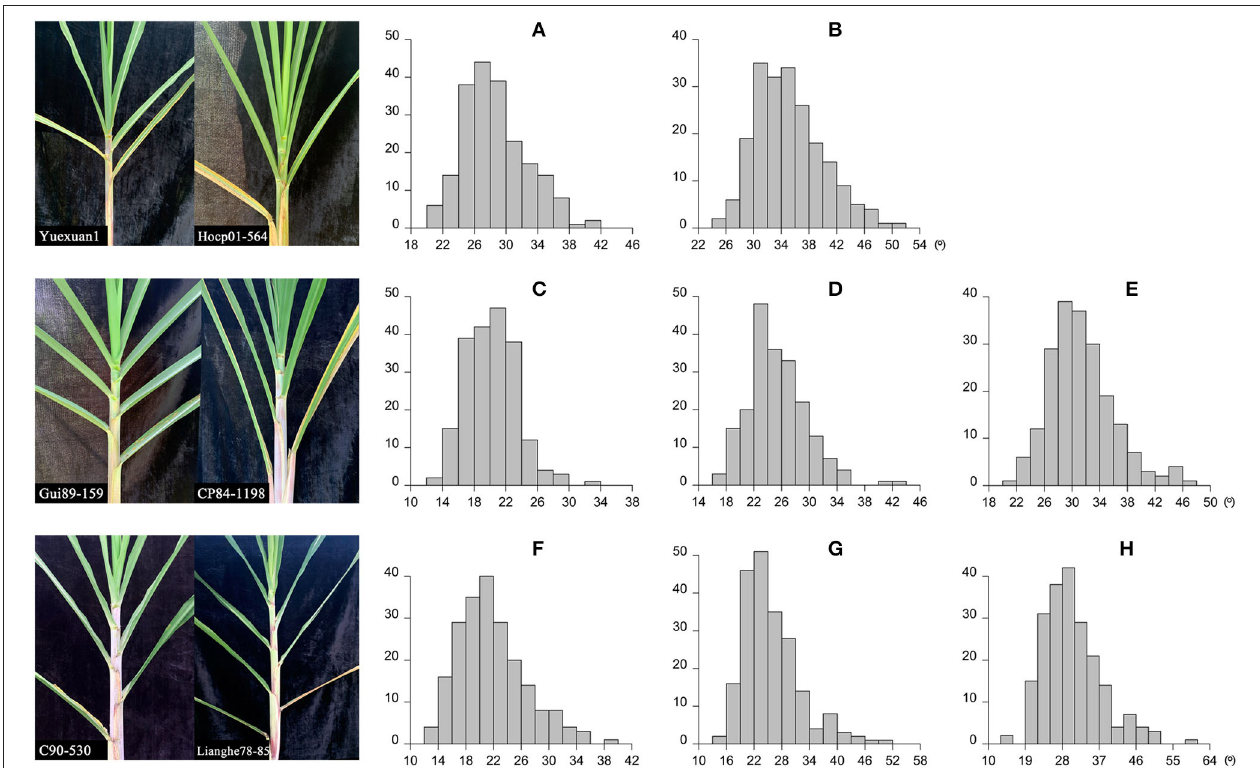
FIGURE 2 | Leaf angle and the frequency distribution in sugarcane different growth stages. (A,B) Indicate the + 2 and + 3 leaf angle in the seedling stage, respectively (206 accessions); (C–E) indicate the + 2, + 3, and + 4 leaf angle in the elongation stage, respectively (203 accessions); (F–H) indicate the + 2, + 3, and + 4 leaf angle in the mature stage, respectively (211